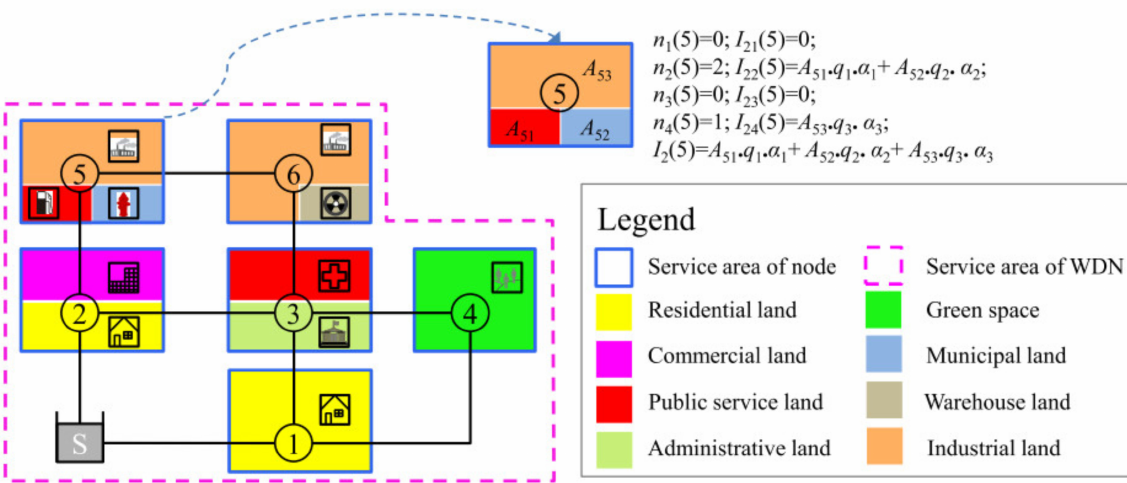
Figure 3. Layout of the example WDS and the service facilities of user nodes.